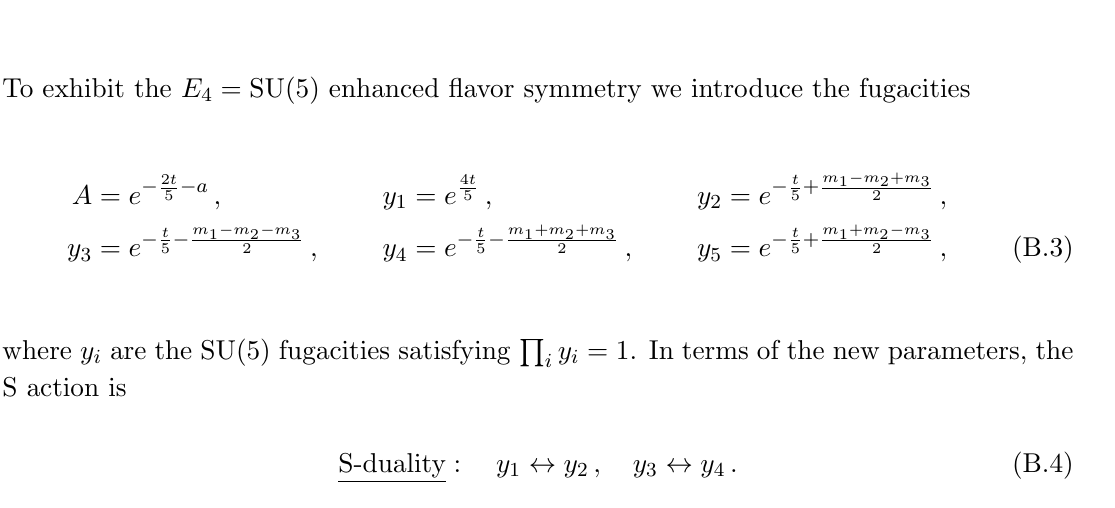
Figure 15 . Brane realization of the SU(2) theory with N f = 3 and brane setup ADHM quiver SQM for the k -instanton